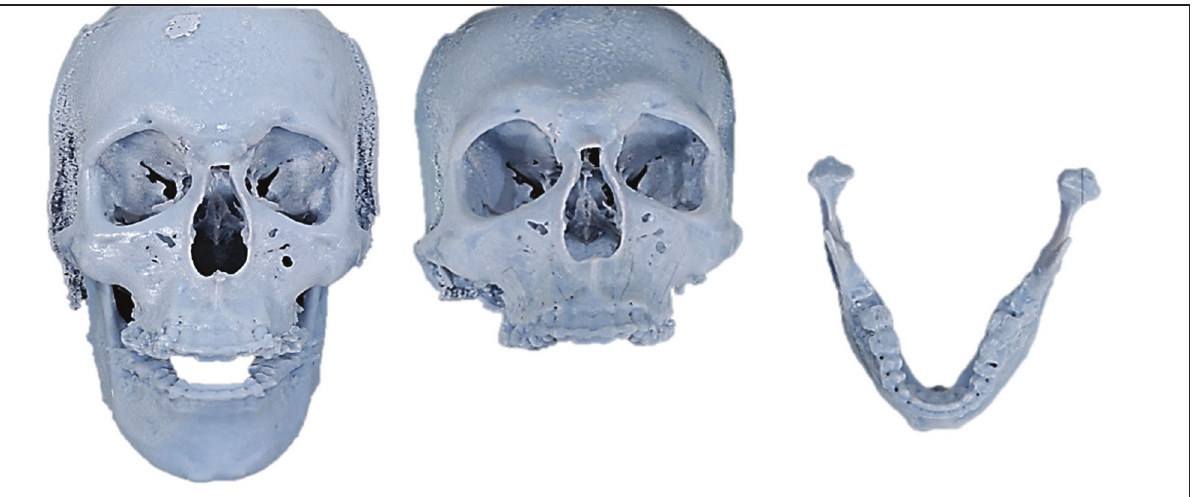
Figure 8. 3D physical skull printing and reproduction with inaccurate dentition and streak artefacts derived from CBCT scan of the